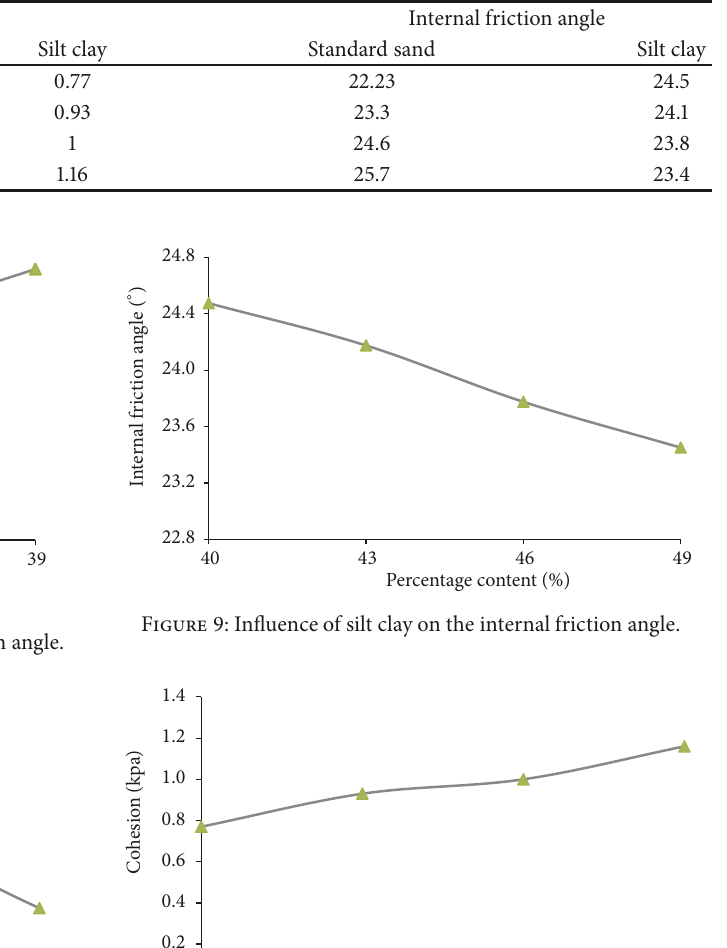
Table 3: Results of extreme difference calculation and analysis.